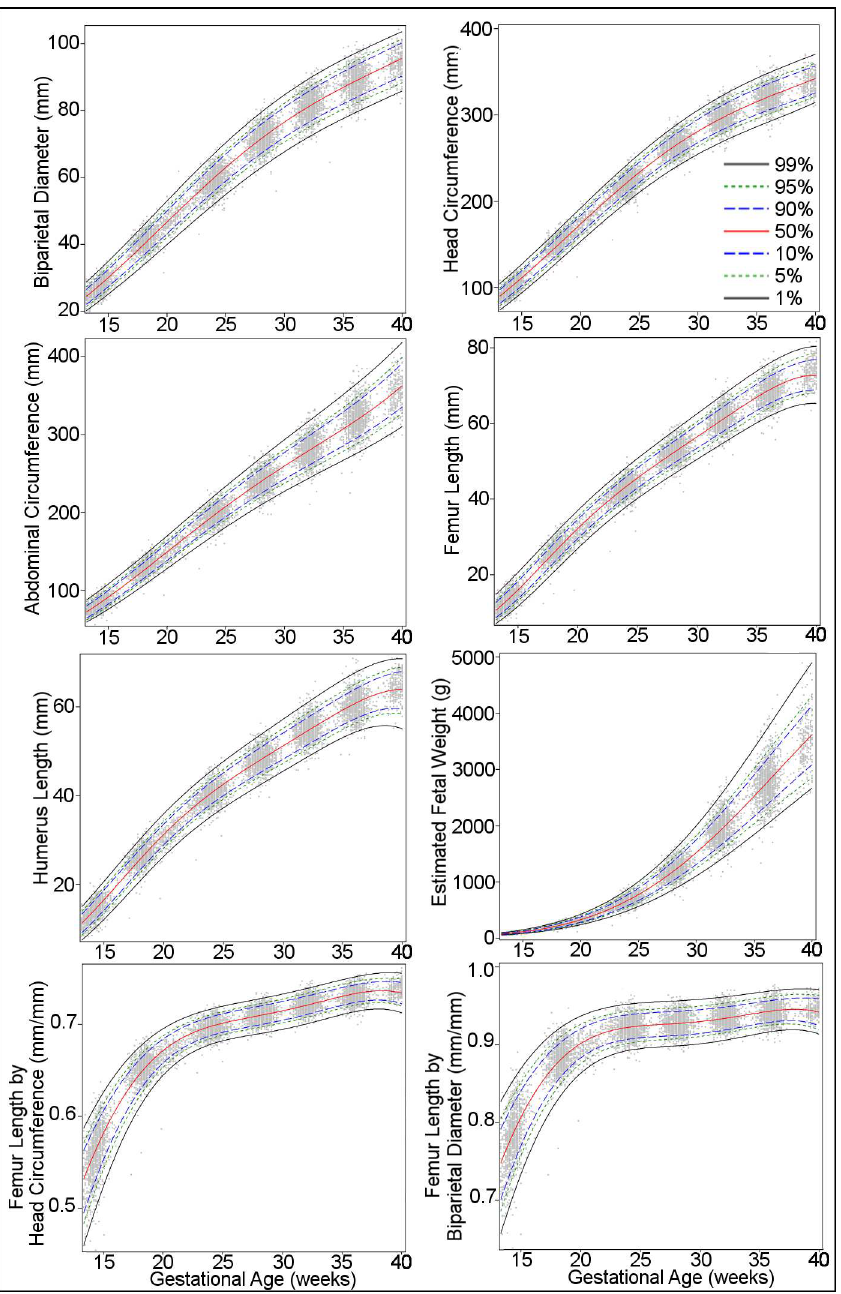
Fig 1. Percentiles for biparietal (outer–inner) diameter, head circumference, abdominal circumference, femur length, humerus length, estimated fetal weight, femur length/head circumference ratio, and femur length/biparietal diameter ratio during gestational weeks 14–40. The percentiles (percent) 1st, 5th, 10th, 50th, 90th, 95th, and 99th (smoothed lines)are basedon quantileregression and are shown with the observedvalues(grey